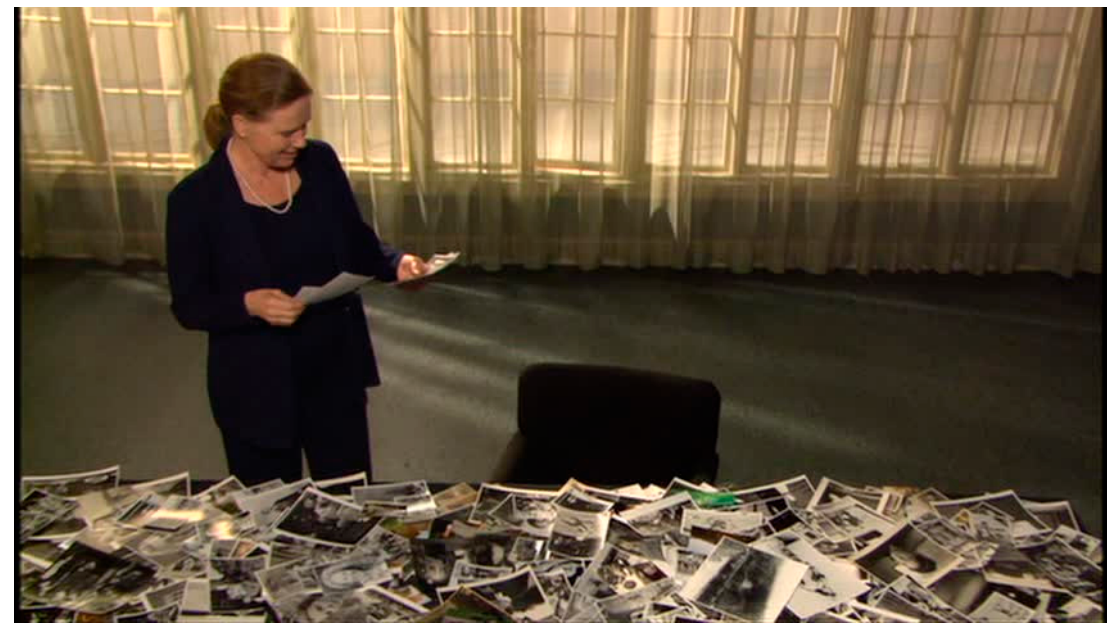
Figure 16. Marianne, her photos, and us.